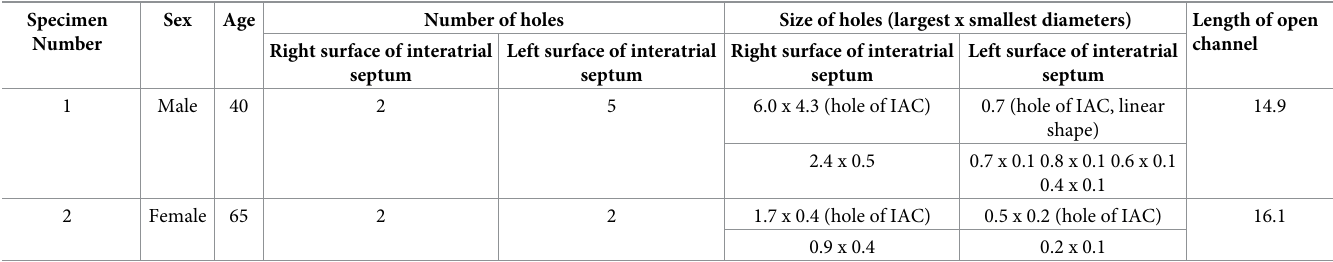
Table 1. Size of holes and channel length of the specimens having the open type IAC (unit: mm). Specimen Number